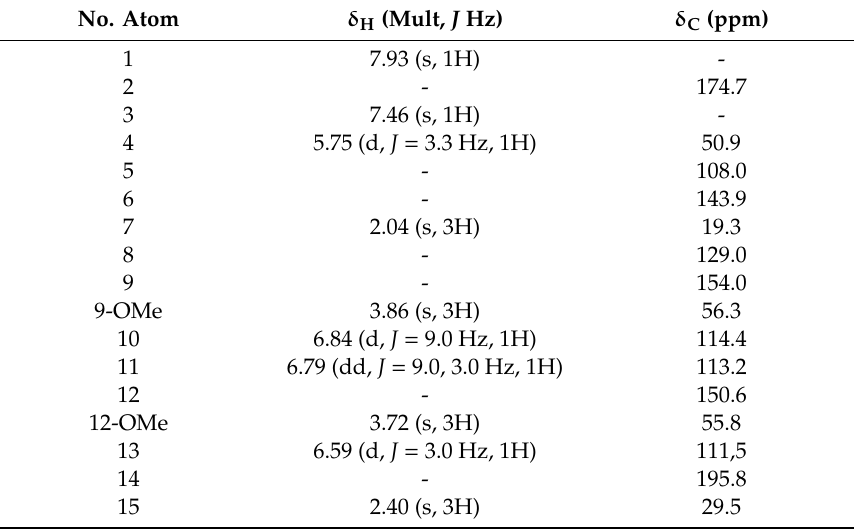
Table 1. Nuclear magnetic resonance (NMR) data of compound 4 in CDCl 3